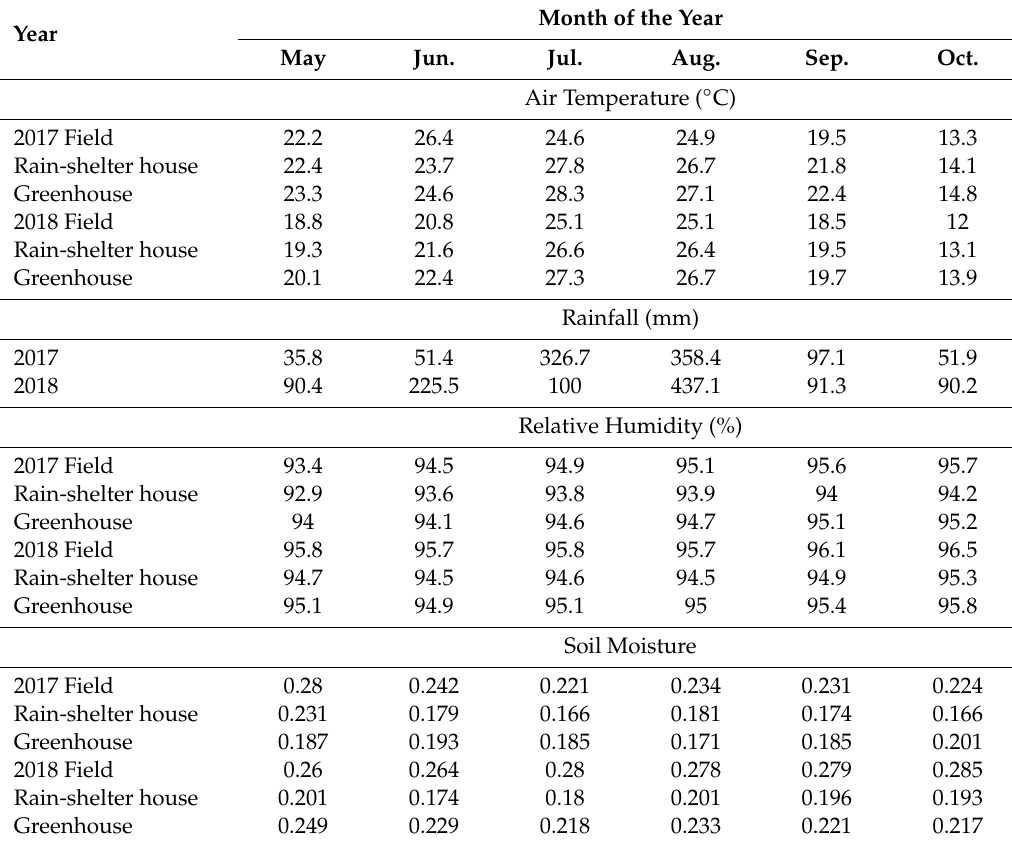
Table 1. Weather data on air temperature, rainfall, and relative humidity of the study area, Chungnam province (2017 to 2018 growing seasons’